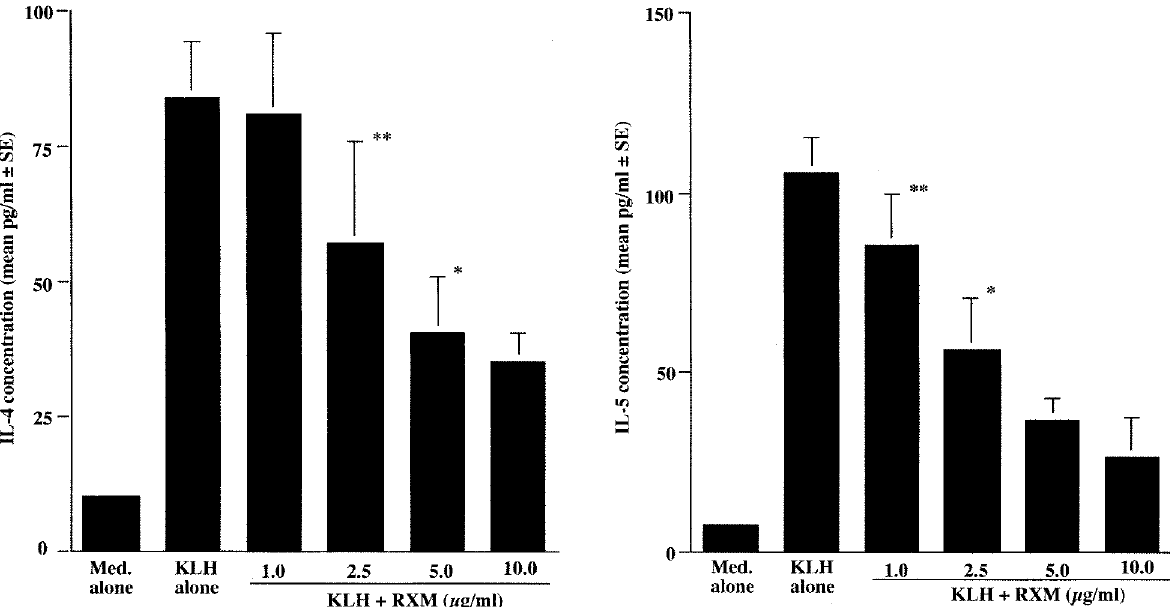
FIG. 2. Influence of RXM on cytokine production from sensitized spleen cells induced by antigenic stimulation in vitro . BALB/c mice were immunized by intraperitoneal injection with 8.0 m g/ml of hemocyanin KLH absorbed to 4.0mg of aluminum hydroxide in a volume of 0.5ml. Spleen cells (1 ´ 10 5 cells/0.1ml) prepared from mice 10 days later were stimulated with 100.0 m g/ml of KLH in the presence of various concentrations of RXM for 24h. Cytokine concentrations in culture supernatants were examined by ELISA. Data represent the mean (pg/ml) ± standard error of five individual mice. * Not significant ( p > 0.05) as compared with KLH alone, ** significant at p < 0.01 as compared with KLH